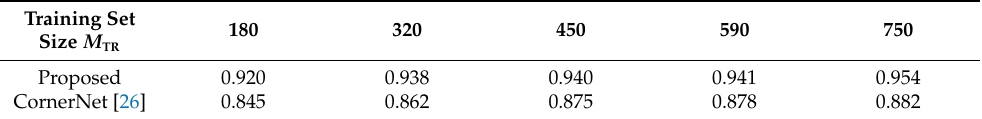
Table 2. The AUROC performance of the proposed algorithm and CornerNet [26] for gesture detection for various sizes of training sets. The ITR ratio for the proposed algorithm was r = 0.3. Training Set Size M TR